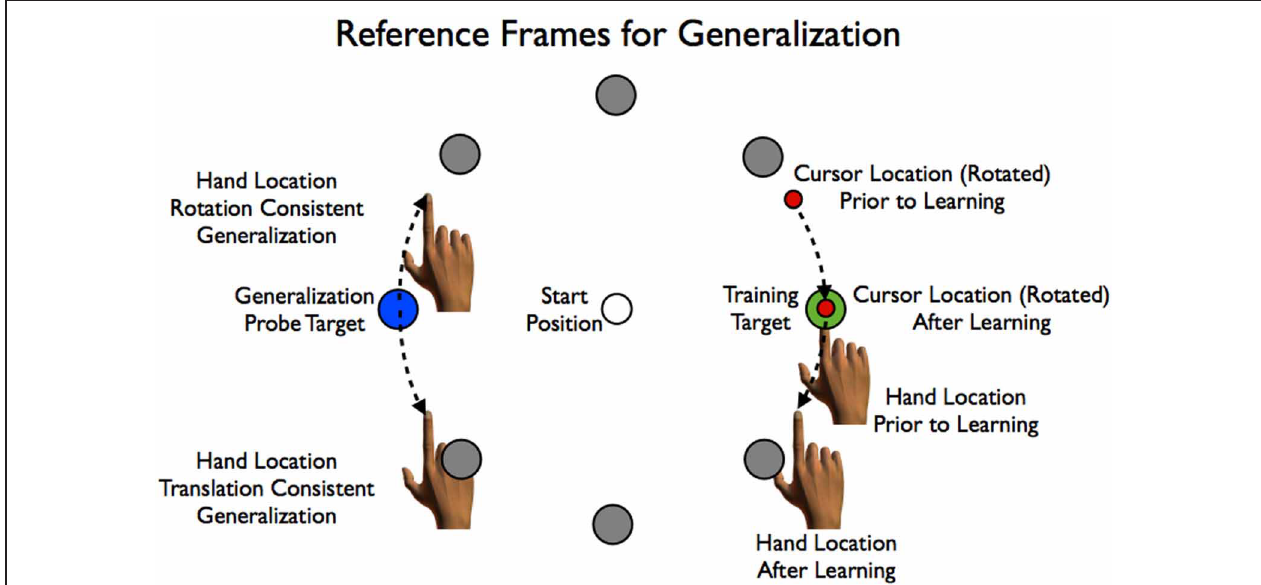
consistent with learning a rotation would appear as a clockwise shift in hand angle for movements to the probe target. Generalization consistent with learning a translation would appear as a counterclockwise shift in hand